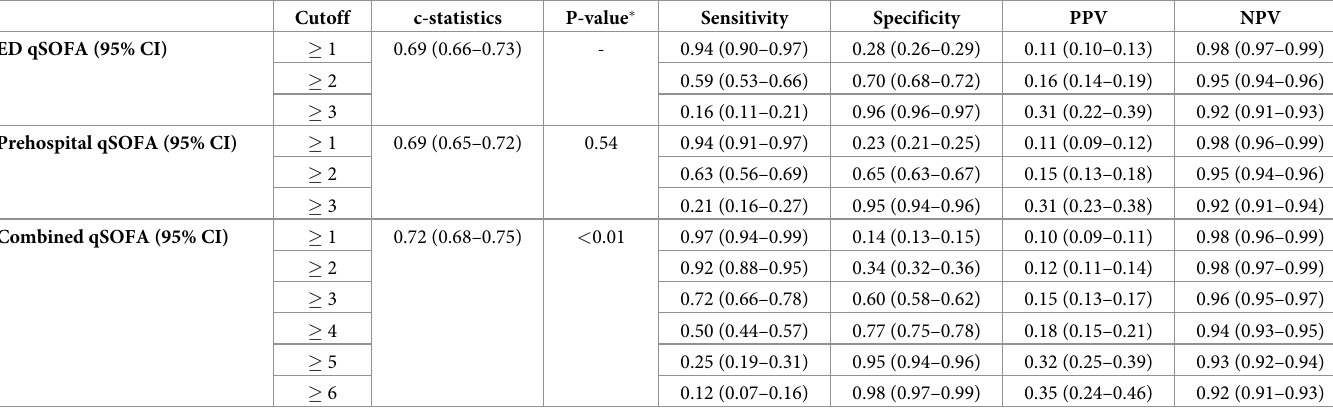
Table 5. Predictive abilities of the ED qSOFA, prehospital qSOFA, and combined qSOFA for in-hospital